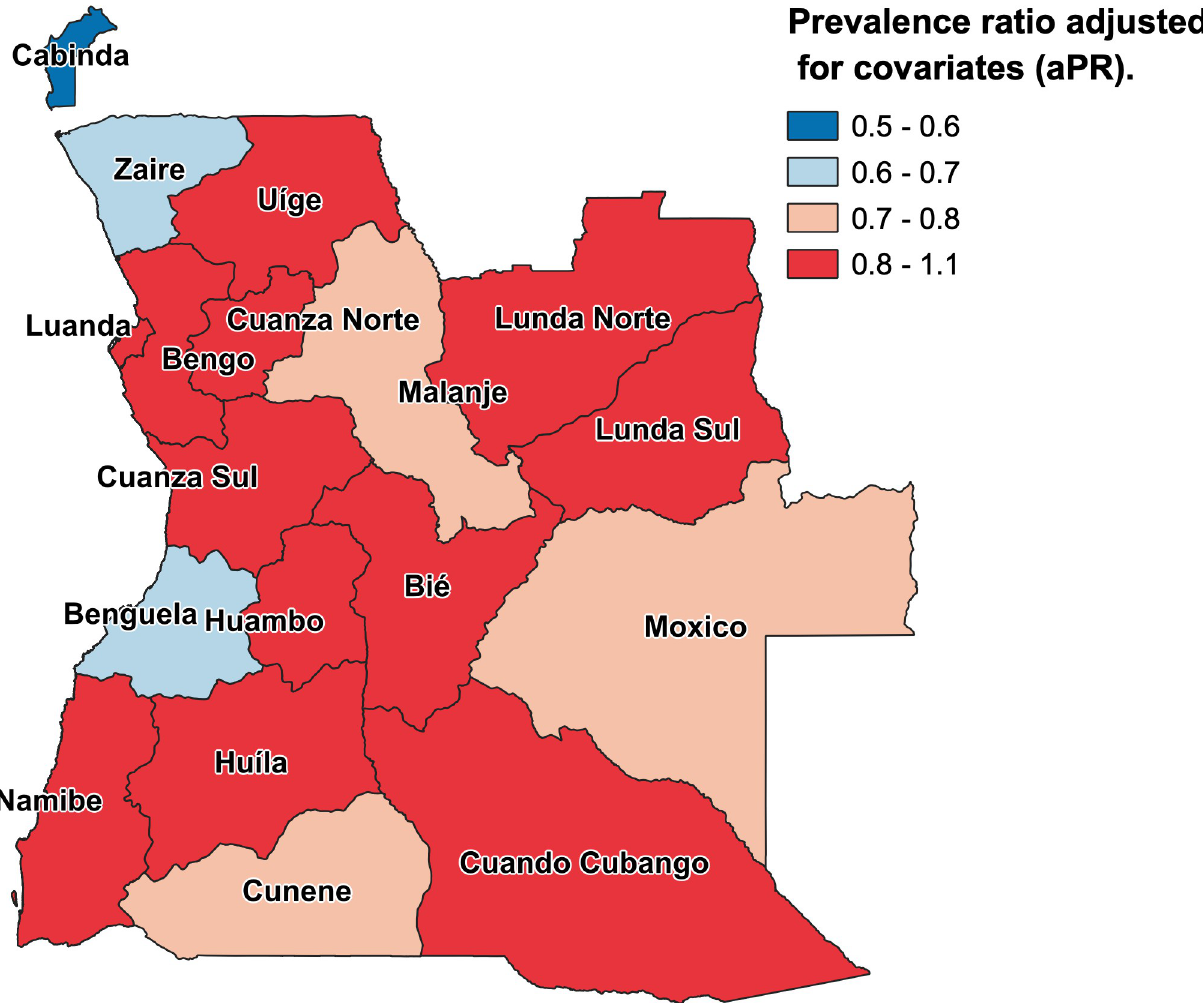
Fig 3. Map of the Republic of Angola displaying prevalence ratio of stunting for each province relative to Luanda. Map shows the territory of the Republic of Angola with the 18 provinces color-coded to display adjusted prevalence ratio of stunting among children 0 to 59 months of age relative to Luanda. Adjusted prevalence ratios were obtained using fixed-effects multivariable Poisson regression model 3 (Table 2). Base layer map shapefile was obtained from GADM (https://gadm.org/maps/AGO.html) [40]. Terms and conditions of use available from https://gadm.org/license.html.